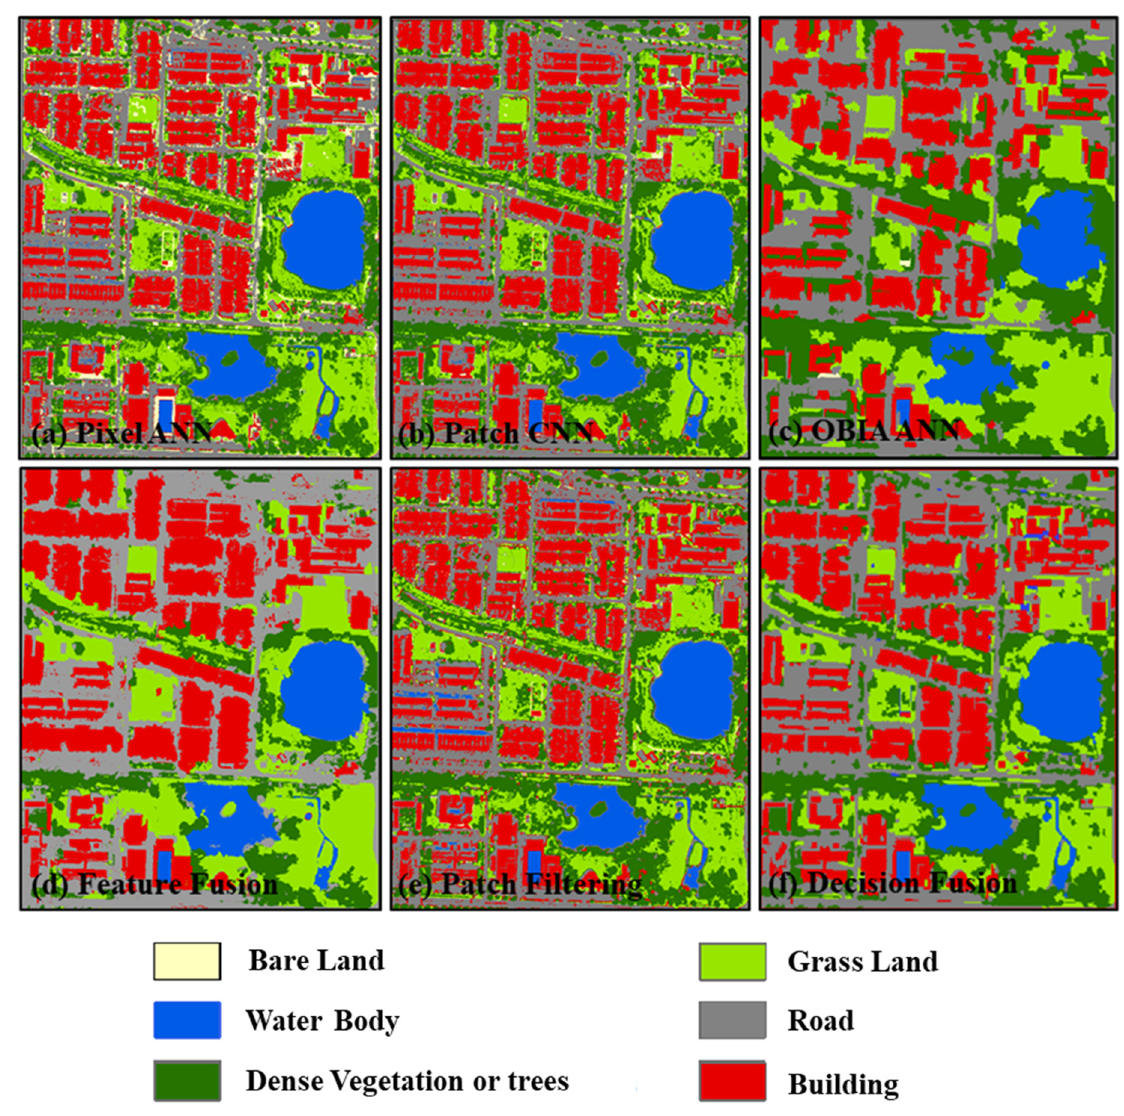
Figure 7. Classification maps obtained for the training area with the pixel ANN, patch CNN, and the four OBIA-CNN integration frameworks assessed in the current research.